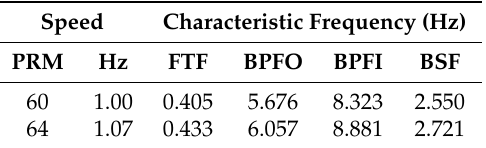
Table 3. The unit characteristic frequencies and the operation characteristic frequencies of the bearing used for the planets in the monitored